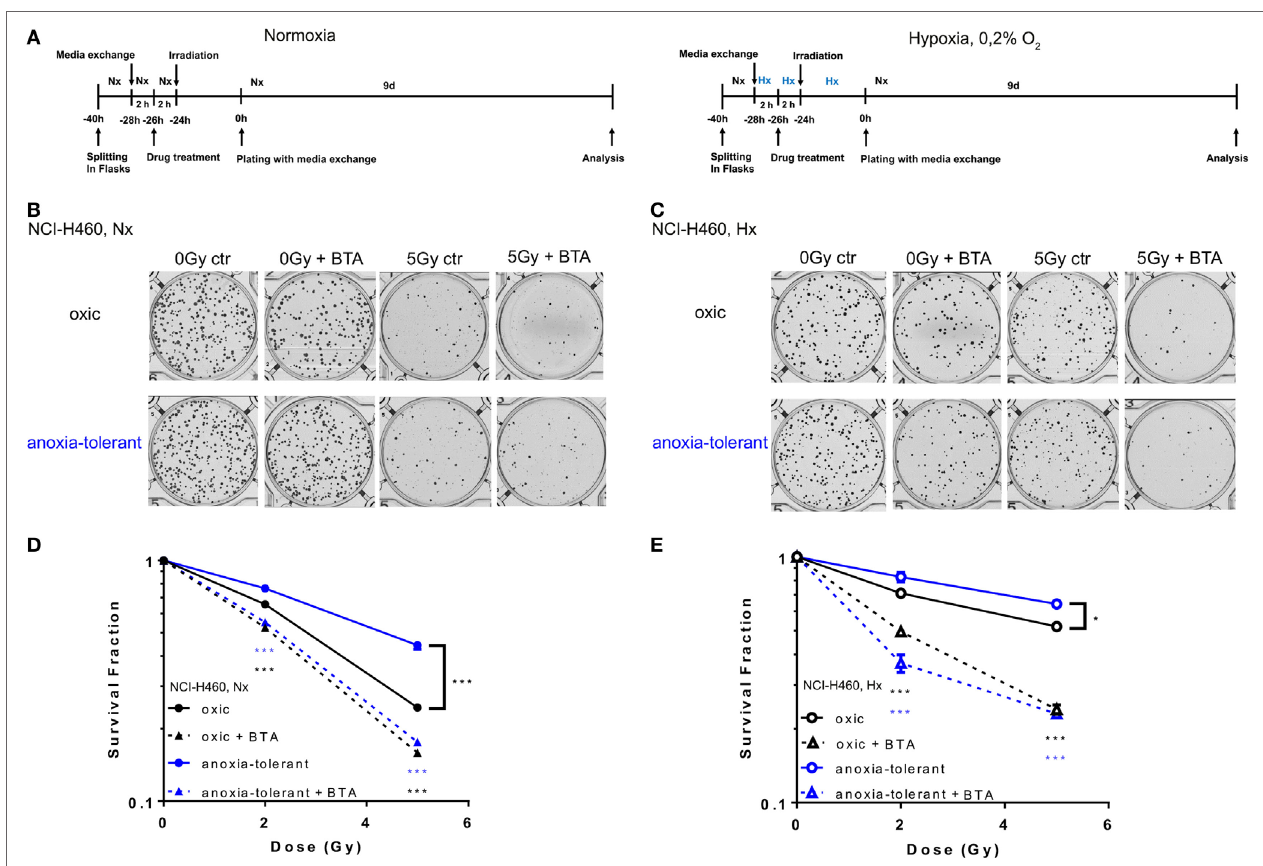
FigUre 3 | Pharmacologic inhibition of SLC25A1 overcomes chronic cycling hypoxia-induced radioresistance. Anoxia-tolerant NCI-H460 cells and the oxic NCI-H460 control cells were pretreated with 5-mM BTA (2 h prior to IR) under normoxic (Nx) conditions (20% O 2 ) or upon 2-h preincubation in severe hypoxia (Hx, 0.2% O 2 ). Twenty-four hours after treatment cells were collected, plated at different cell numbers (200–3,200) in full medium without the inhibitor and grown under Nx for 9 days. (a) Schematic representation of the experimental timeline in normoxia (Nx, left panel) or severe Hx (right panel). Photomicrographs in (B) and (c) show representative pictures of colony formation upon treatment with IR without or with prior BTA treatment for Nx (B) or severely hypoxic conditions (c) . Survival curves shown in (D,e) depict quantification of colony formation upon treatment in normoxia (D) and severe hypoxia (e) . Colonies were scanned and counted using GelCount. Survival fractions were calculated to the plating efficiency of unirradiated cells under Nx or Hx conditions. Mean values ± SEM are shown, n = 3 (* p ≤ 0.05, ** p < 0.01, and *** p ≤ 0.001; two-way ANOVA with Tukey post-test.) Comparisons between treatment and corresponding controls at the same dose are